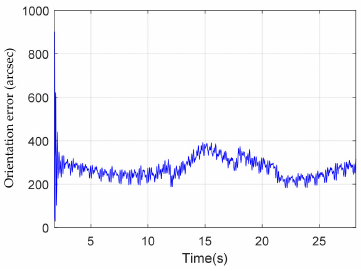
Figure 12. Experimental results: the orientation